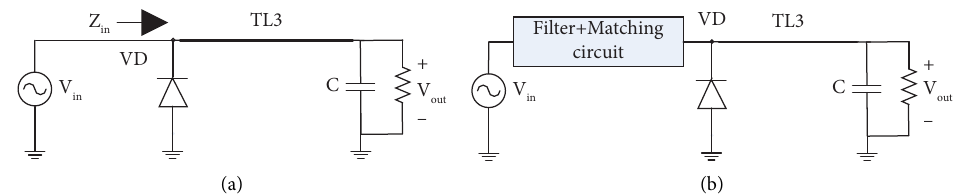
Figure 10: (a) Measuring circuit of SBD input impedance. (b) Rectifying